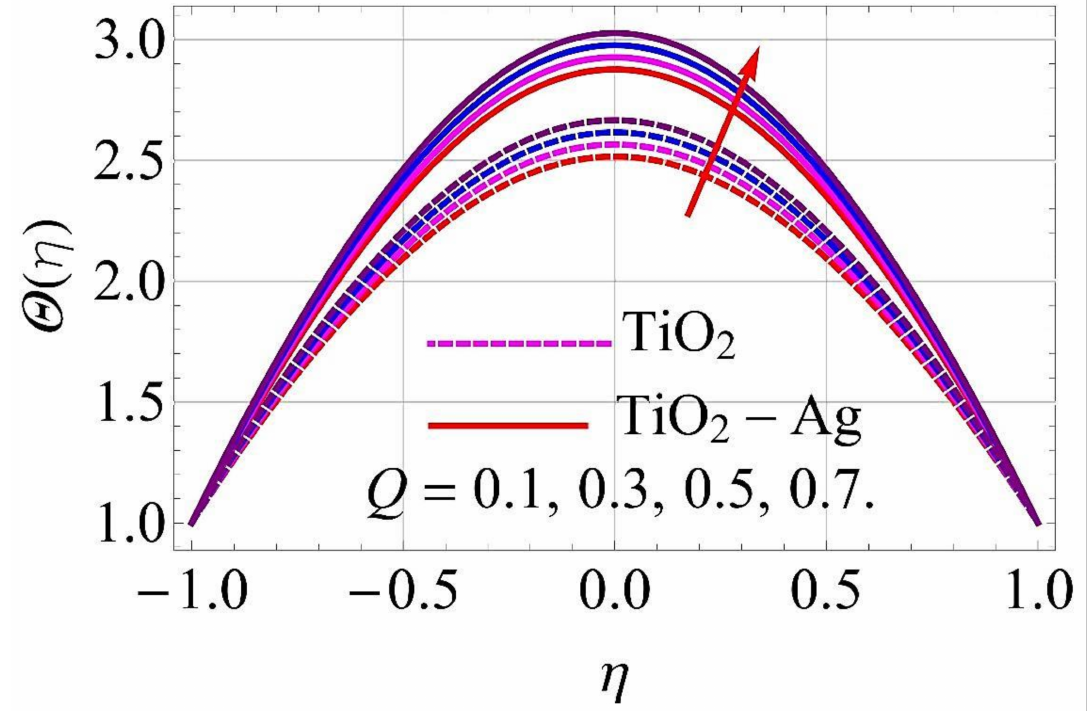
Figure 22. Temperature versus Q with α = 5 ◦ for diverging/shrinking circumstances. When Re = 25, φ 1 = φ 2 = 0.01, Rd = 0.4, Ec = Ha = k ∗ = Fr = K 1 =